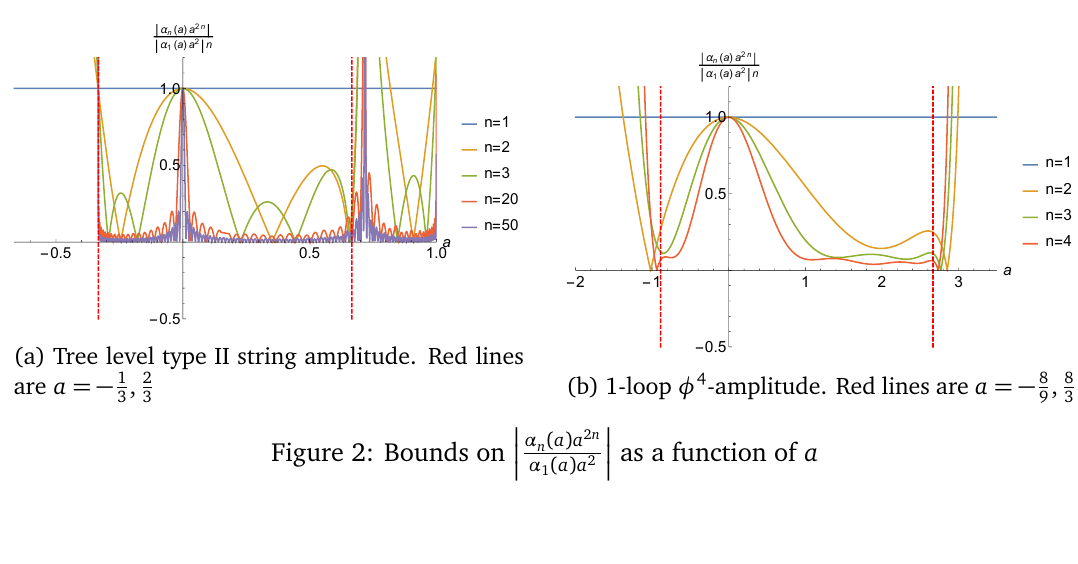
(cid:12) α ( a ) a 2 n (cid:12) n (cid:12)